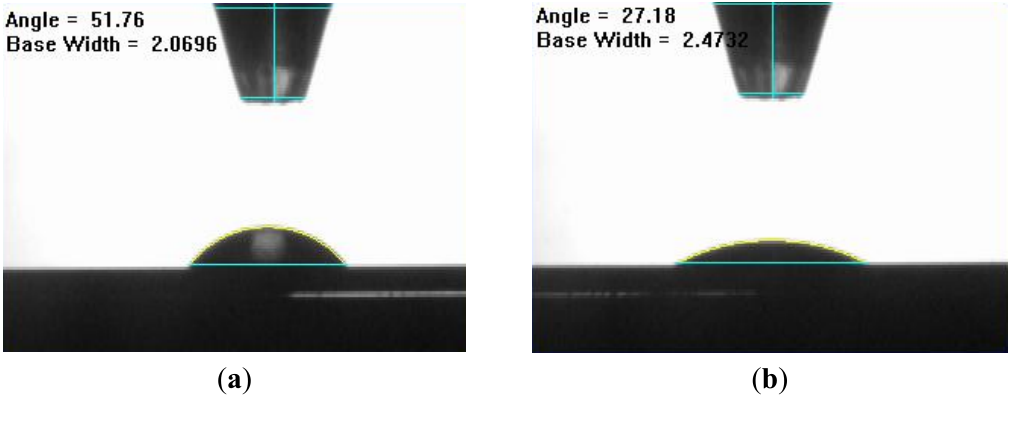
Figure 4. Effect of surfactant on surface tension: ( a ) 3 µL droplet of water without surfactant; and ( b ) 3 µL droplet of water with surfactant. Surfactant clearly decreases the surface tension of the